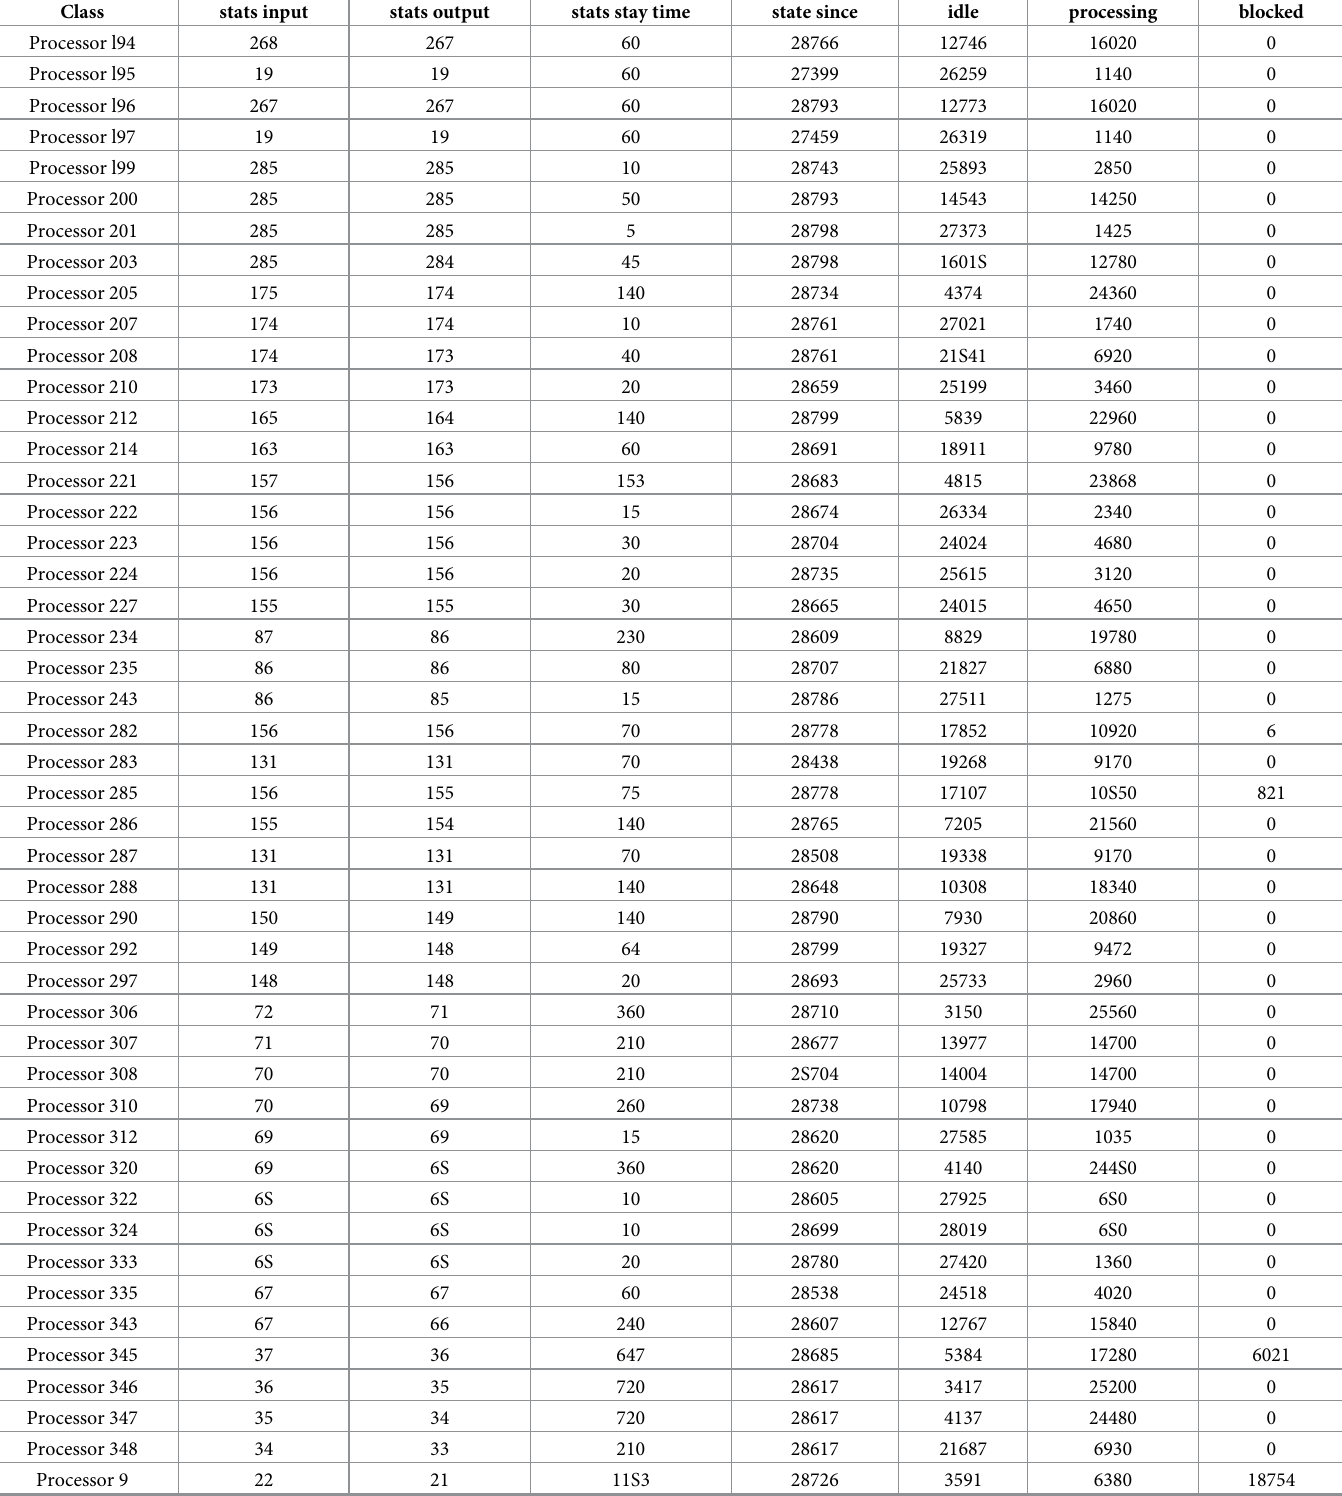
Table 8. Initial simulation